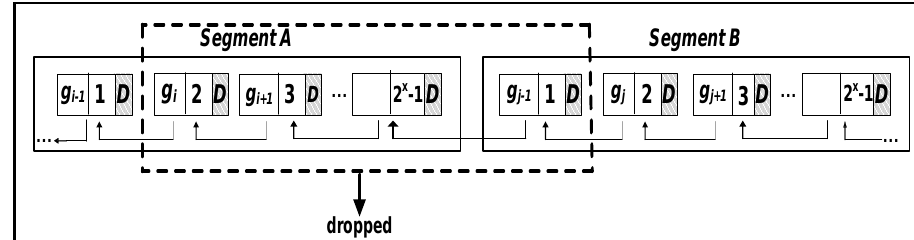
Figure 6. FWC-D: Segment Deletion Attack